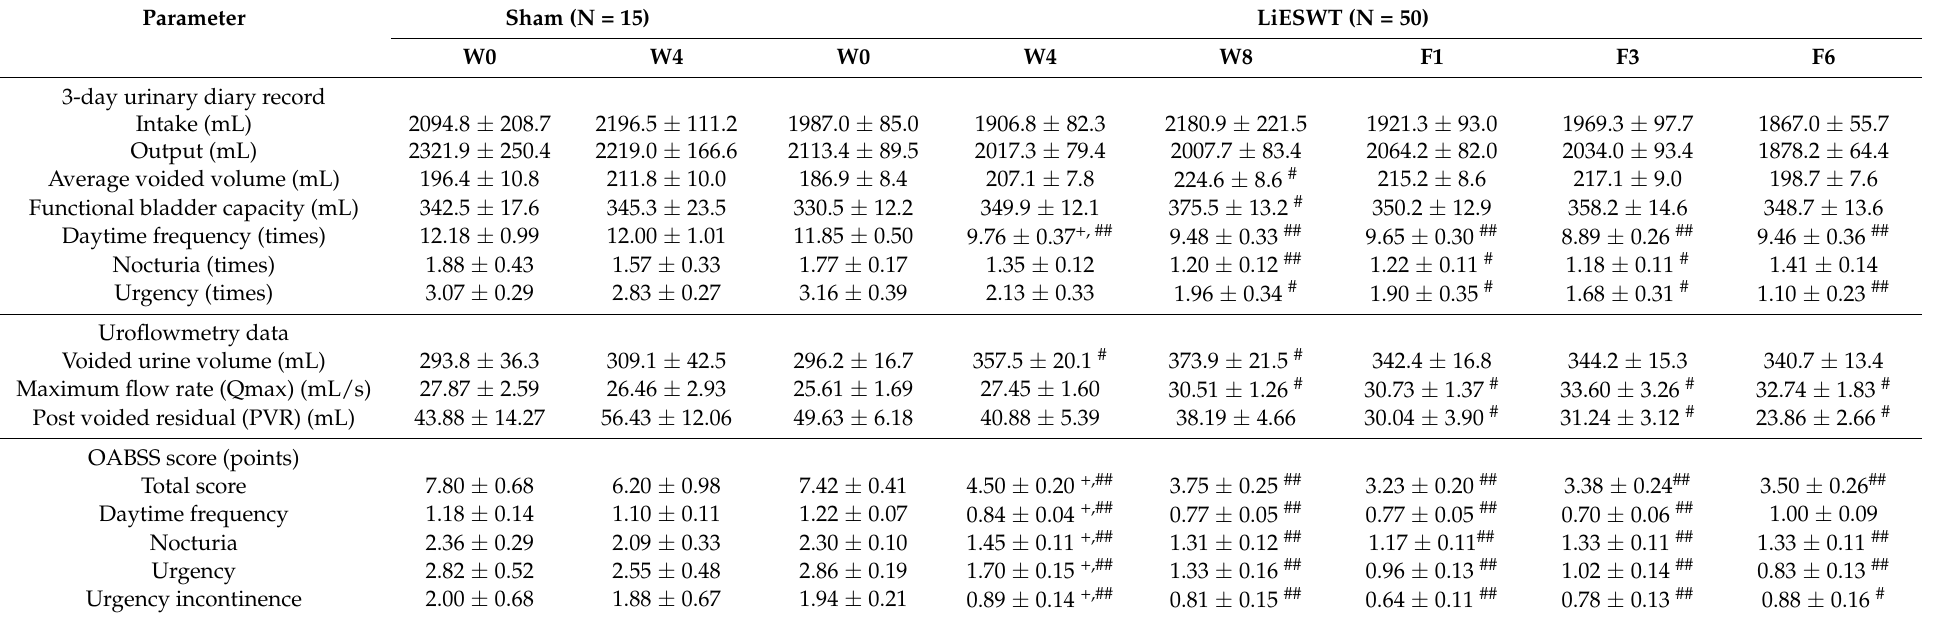
Table 3. Urodynamic parameters of study population for overactive bladder